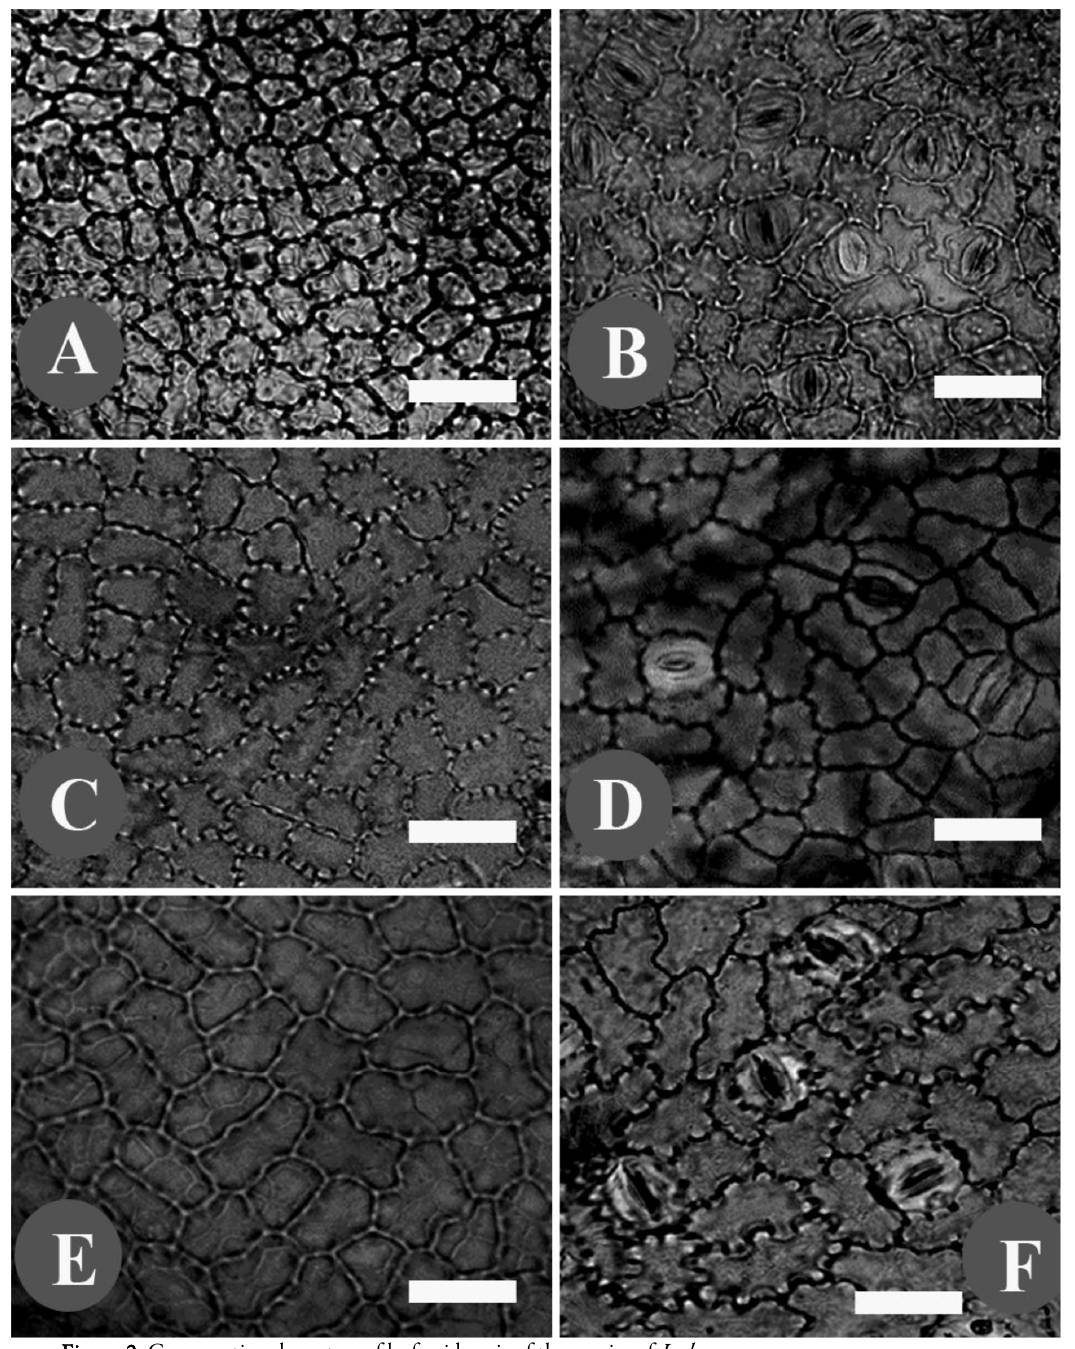
Figure 2. Comparative characters of leaf epidermis of the species of Isolona A, C and E: Adaxial surfaces, B, D and F: Abaxial surfaces. A, B- Isolona pleurocarpus, C, D- I. thonneri , E, F- I. zenkeri Scale bar- 25